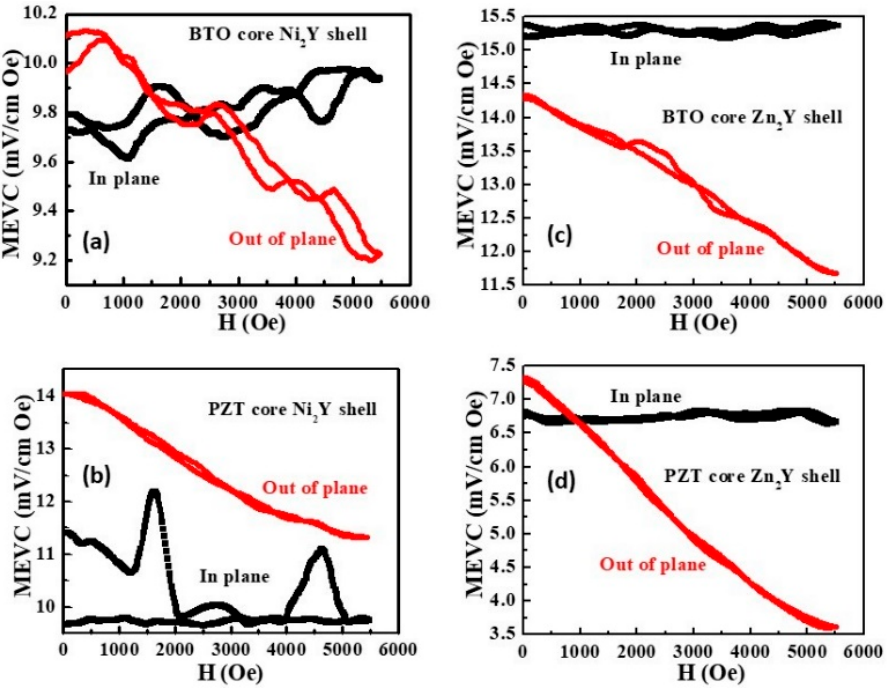
Figure 13. MEVC vs. H data for films of ferroelectric core and shells of Y-type hexaferrites. ( a ) BTO and Ni 2 Y, ( b ) PZT and Ni 2 Y, ( c ) BTO and Zn 2 Y, and ( d ) PZT and Zn 2 Y.